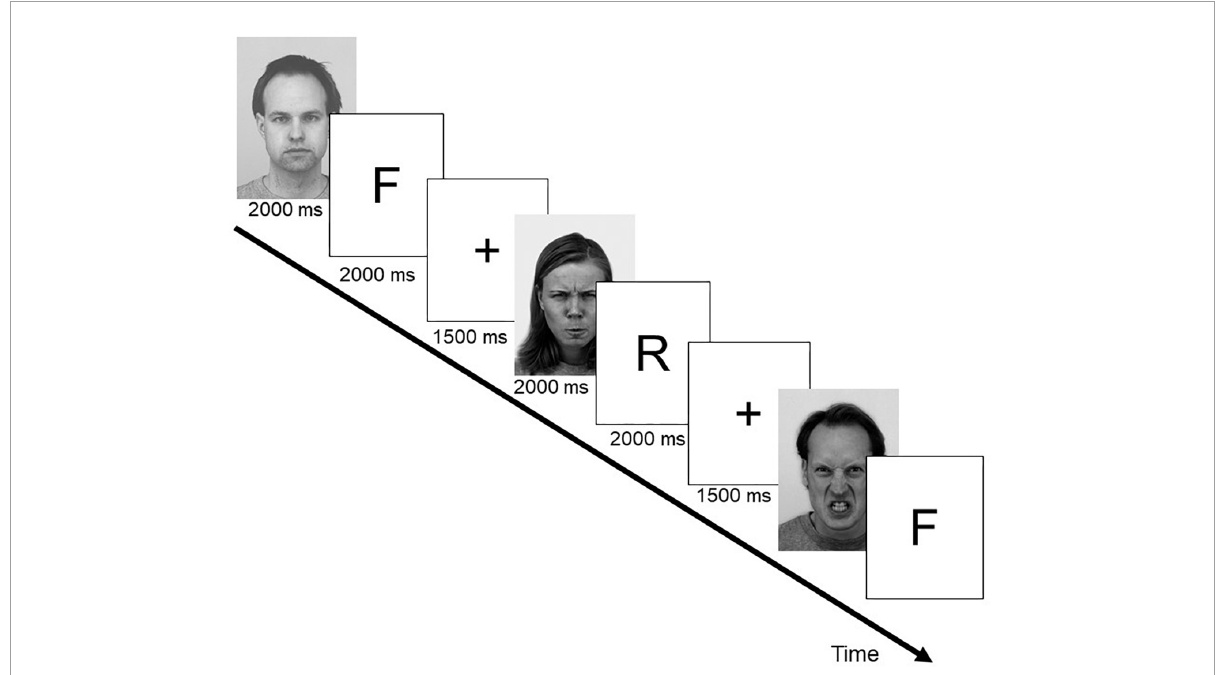
FIGURE1 Exemplary trial sequence and timing parameters for the encoding phase of the directed forgetting experiment. F represents a forget cue, denoting the previous face as “to-be-forgotten,” R indicates a remember cue denoting the previous face as to “to-be-remembered.” Example faces shown here are from the KDEF database (Lundqvist et al., 1998). Shown are KDEF #AM10ANS,#AF19ANS, and